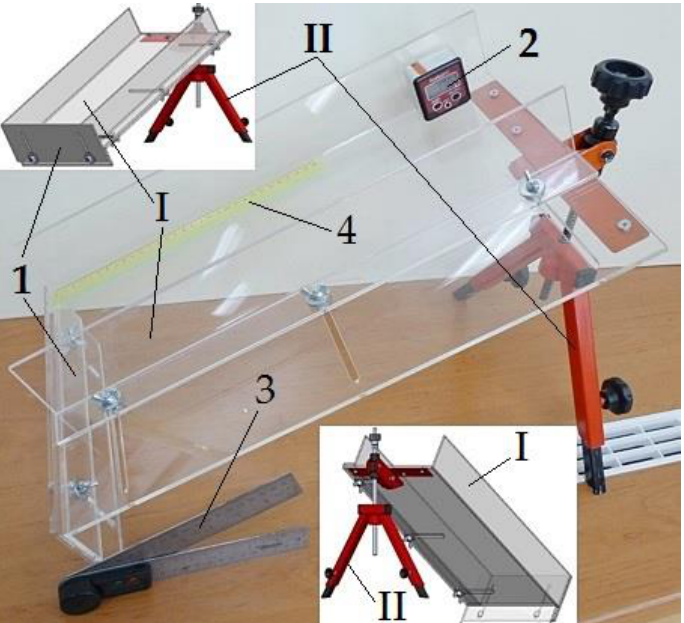
Figure 3. Testing device to determine shape, volume, and length of spread material batches ( I ) - trough, ( II ) - tilting mechanism, ( 1 ) - sliding plate, ( 2 ) - digital inclinometer, ( 3 ) - digital protractor, ( 4 ) - ruler.